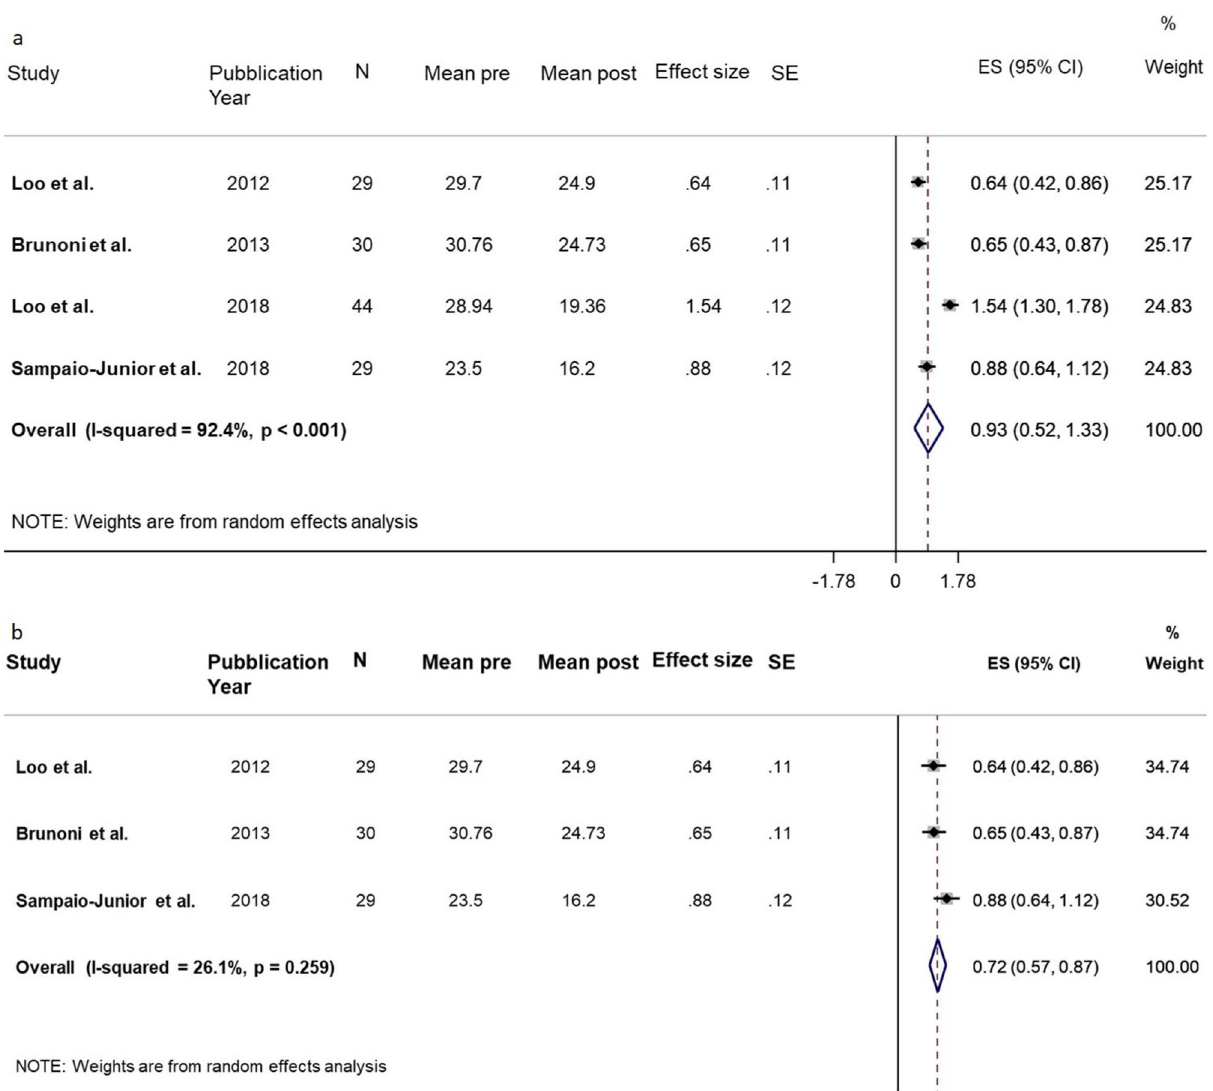
Figure 3. Depression. Sham. ( a ) Forest plot of meta-analysis results considering all studies. The diamond represents the pooled standardized mean difference (SMD, dashed red vertical line) and its 95% confidence interval; vertical solid dark line is the line of equivalence. The estimates for each study and their 95% confidence intervals are represented by a box with whiskers, the dimension of grey box is proportional to the precision of the study. ( b ) Forest plot of sensitivity meta-analysis. Note: SE = Standard Error; ES = Effect Size. CI = Confidence